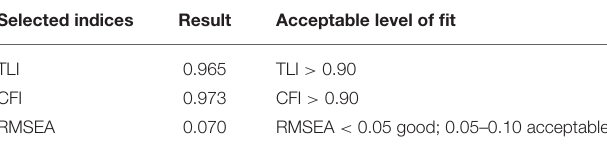
TABLE 5 | Threshold of goodness-of-fit